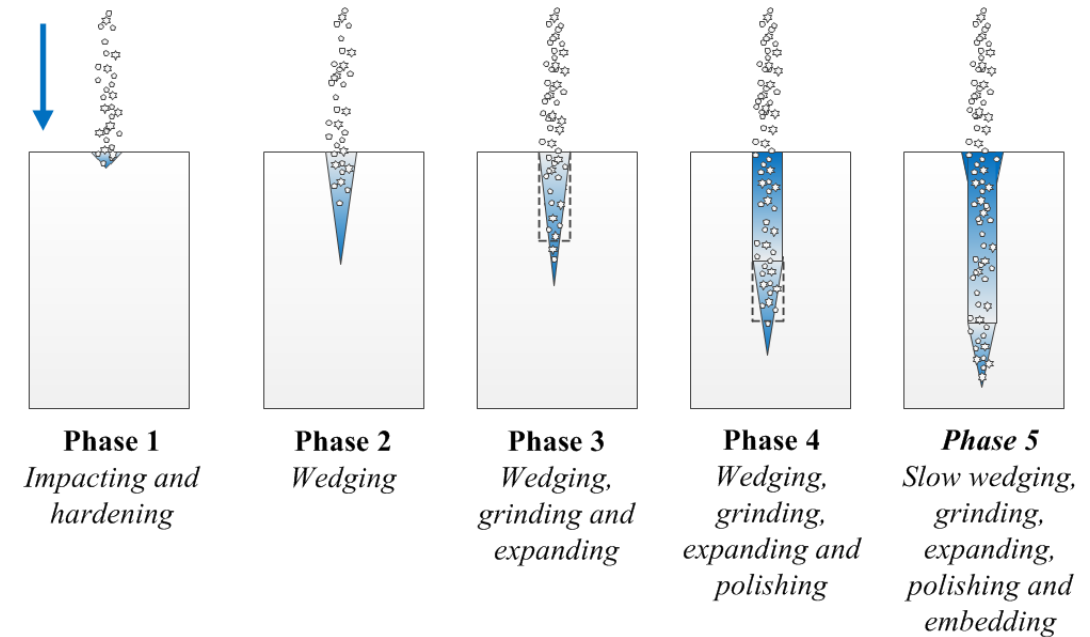
Figure 10. Five phases in the jet-cutting process (the blue kerf is assumed to develop primarily in the longitudinal